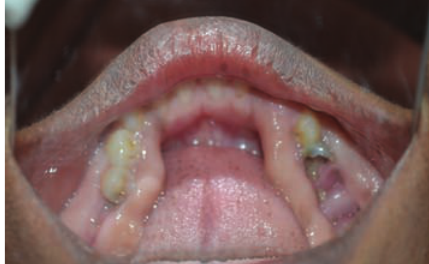
Figure 10: Clinical picture showing gingival enlargement in poste- rior